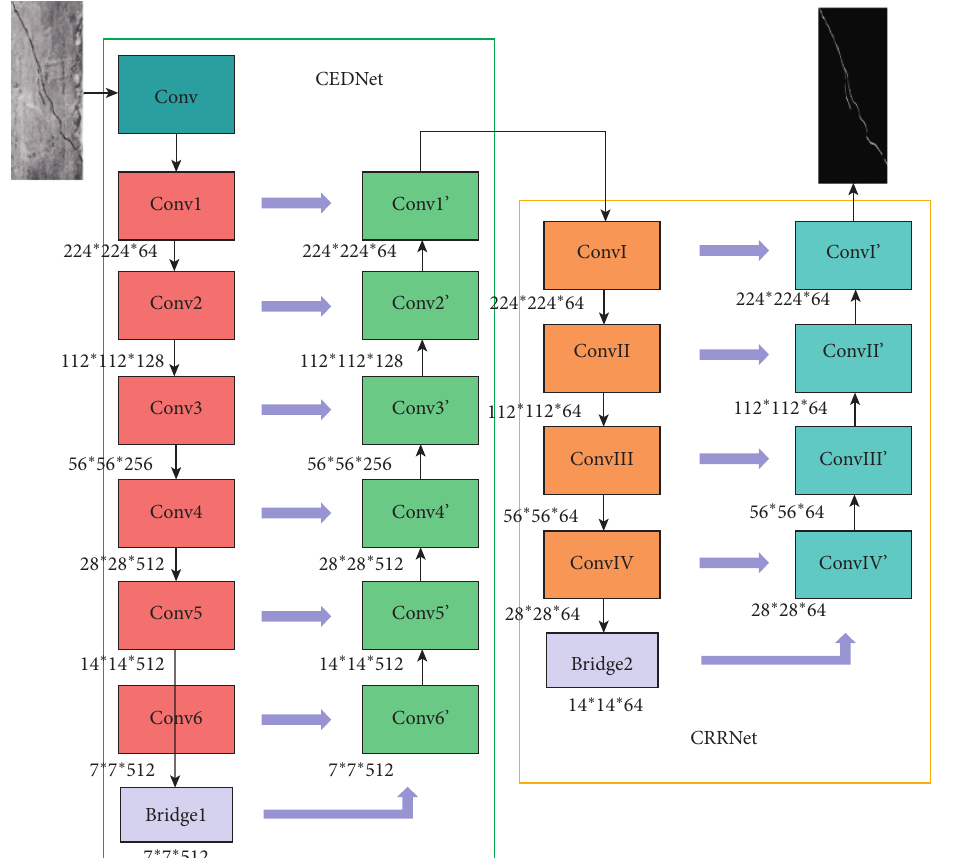
Figure 5: Crack recognition module.